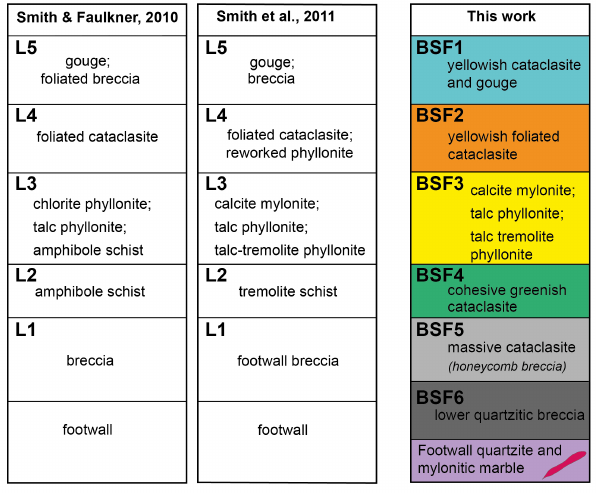
Table 1. Definition of brittle structural facies in this work and com- parison with existing classifications of the various fault rocks asso- ciated with the ZF. Colours correspond to those of Fig.